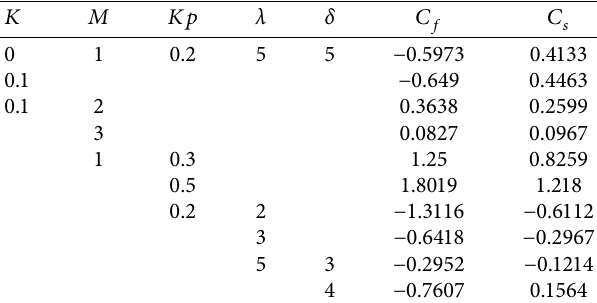
t (b) Kc Nb Nt on concentration profile. , , (c) , and Table 1: Skin friction and wall couple stress